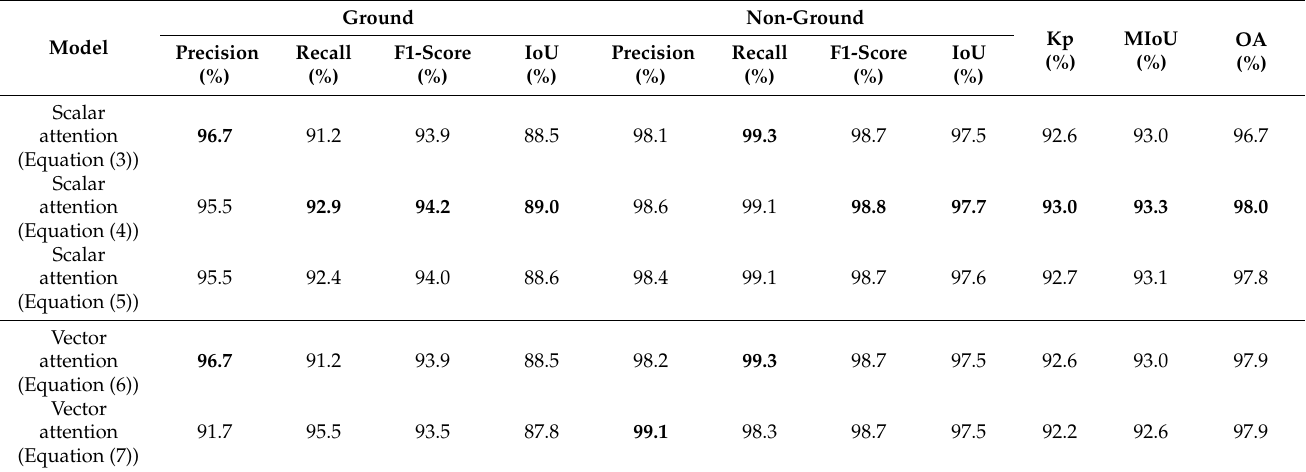
Table 5. The effect of different self-attention block design.